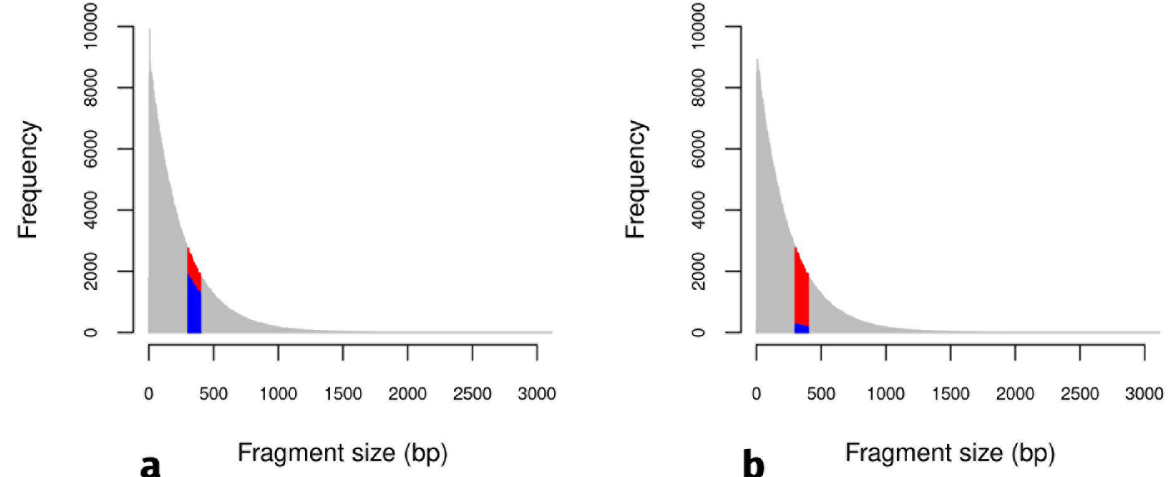
Figure 1. Histograms of in silico simulations (Numbers of fragments versus fragment size). (a) In silico digestion with PstI/MboI. (b) In silico digestion with Sph/MboI. The colored areas represent the portion of fragments of 300- 400bp length. Blue areas specify only those fragments that also have the configuration AB+BA (i.e. were digested with different